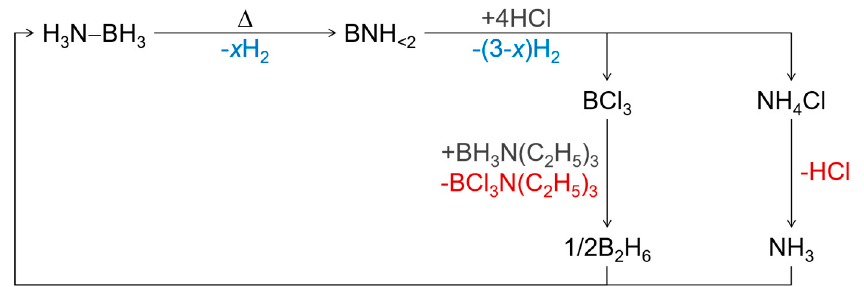
Figure 20. Regeneration of ammonia borane by acidic digestion of the solid residue BNH < 2 , followed by hydrodechlorination of boron trichloride and decomposition of ammonium chloride into ammonia, and finally a Lewis acid–base reaction between diborane and ammonia. Adapted from ref. [325].